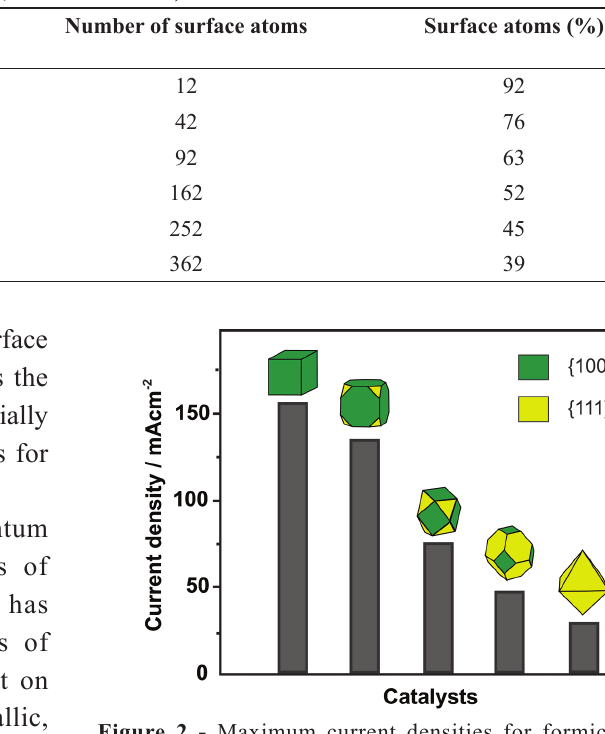
Atoms percentage (%) at a metal nanoparticle surface as a function of the total number of atoms and shells (Xia et al. 2009, Niu and Lu 2015).